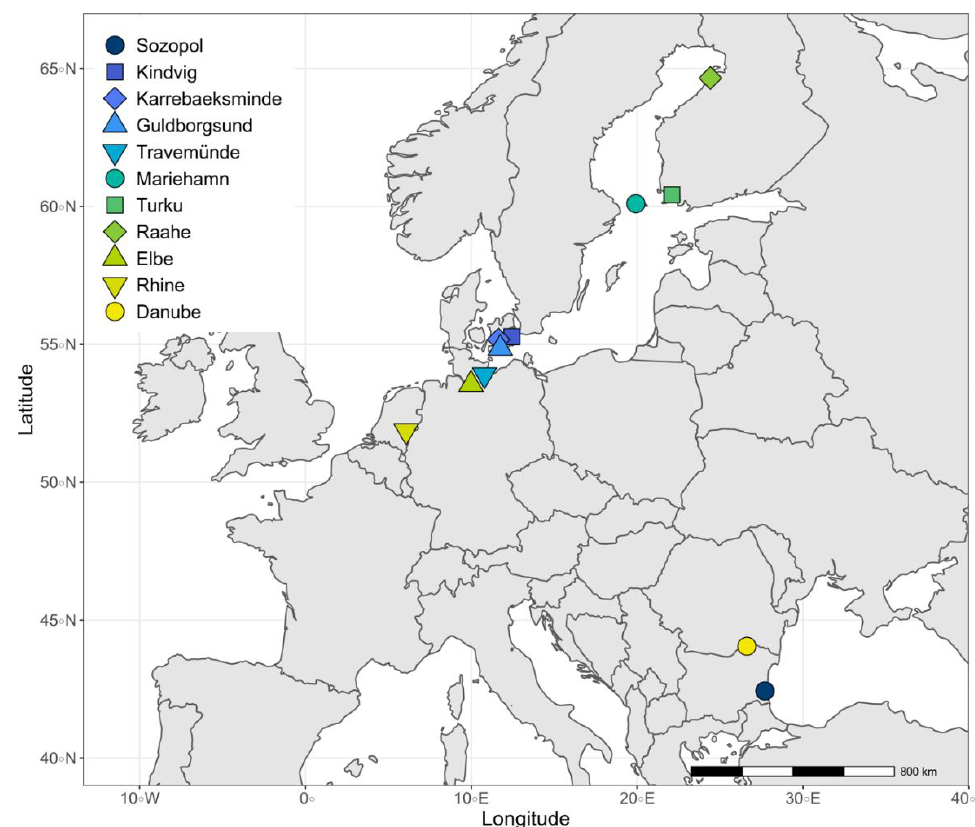
Figure 1. Sites in northern Europe and the ancestral Black Sea region sampled for the invasive fish Neogobius melanostomus (see Supplementary Table S1 for coordinates and associated environmental data). Sozopol (round, dark blue) in the brackish Black Sea, and the river Danube (round, yellow) are ancestral sites sampled for sperm measurements. All other sites represent introduced areas that were sampled during previous studies.